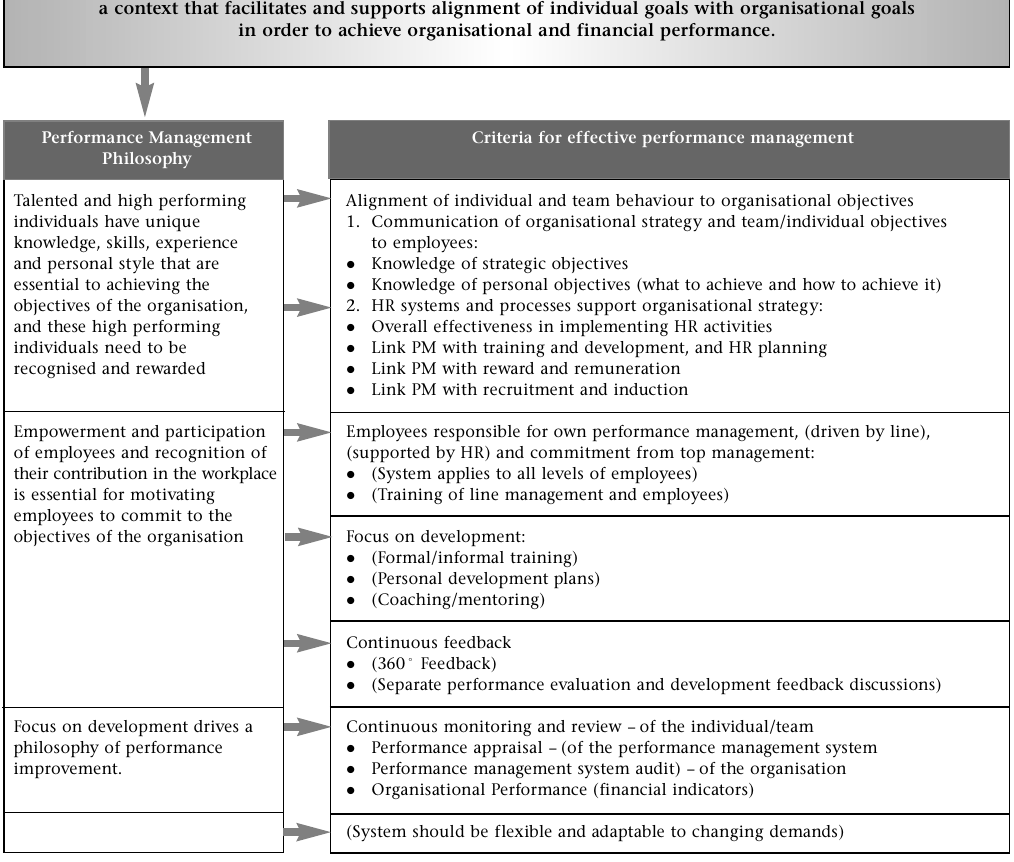
Figure 3: A new model of performance management philosophy and criteria for